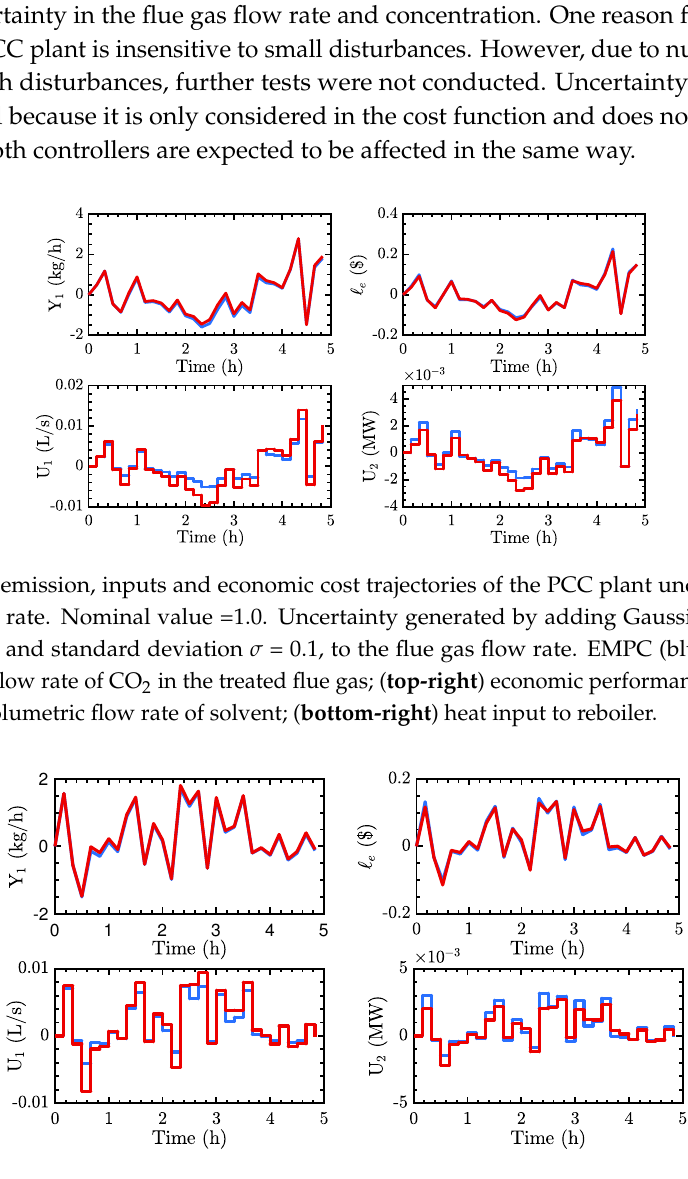
Figure 16. CO 2 emission, inputs and economic cost trajectories of the PCC plant under uncertainty in flue gas CO 2 concentration. Uncertainty generated by adding Gaussian white noise with zero mean and standard deviation σ = 0.06, to the flue gas CO 2 concentration. EMPC (blue), MPC (red); ( top-left ) mass flow rate of CO 2 in the treated flue gas; ( top-right ) economic performance of controller; ( bottom-left ) volumetric flow rate of solvent; ( bottom-right ) heat input to